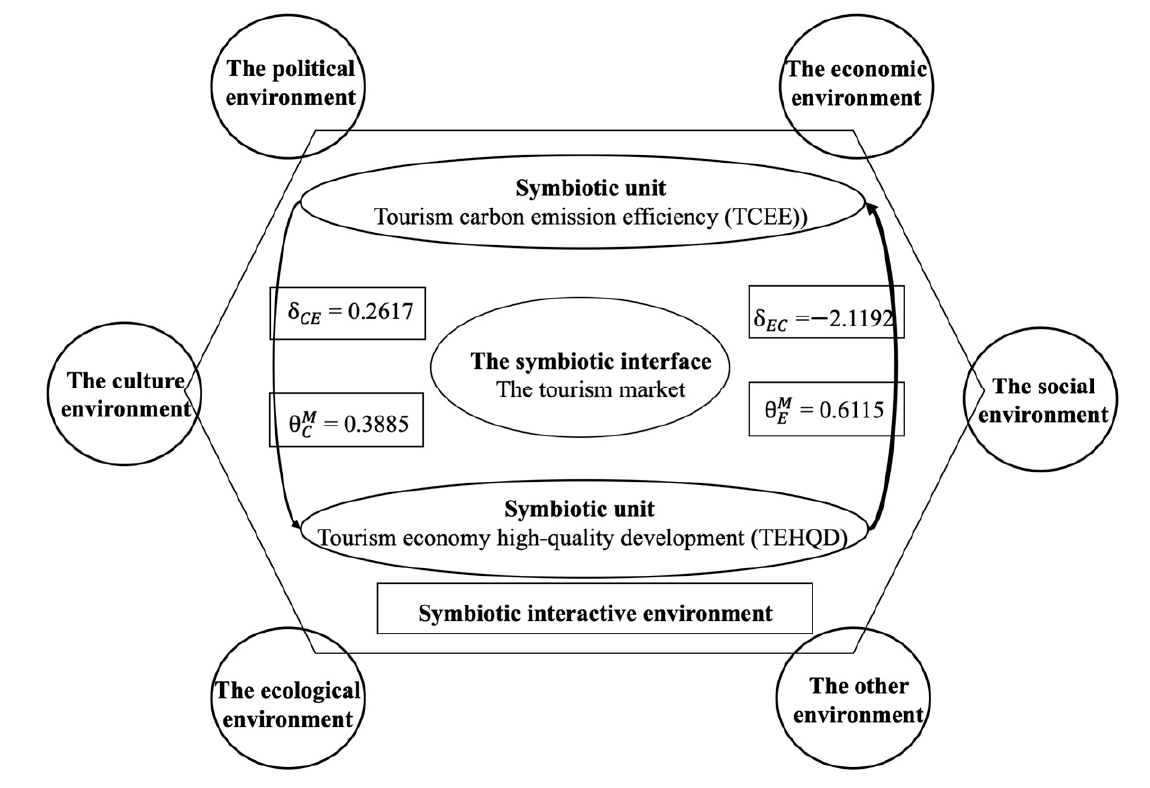
Figure 2. Symbiotic interaction mechanism model of tourism’s carbon emission efficiency (TCEE) and the tourism economy’s high-quality development (TEHQD) in the Yellow River Basin.